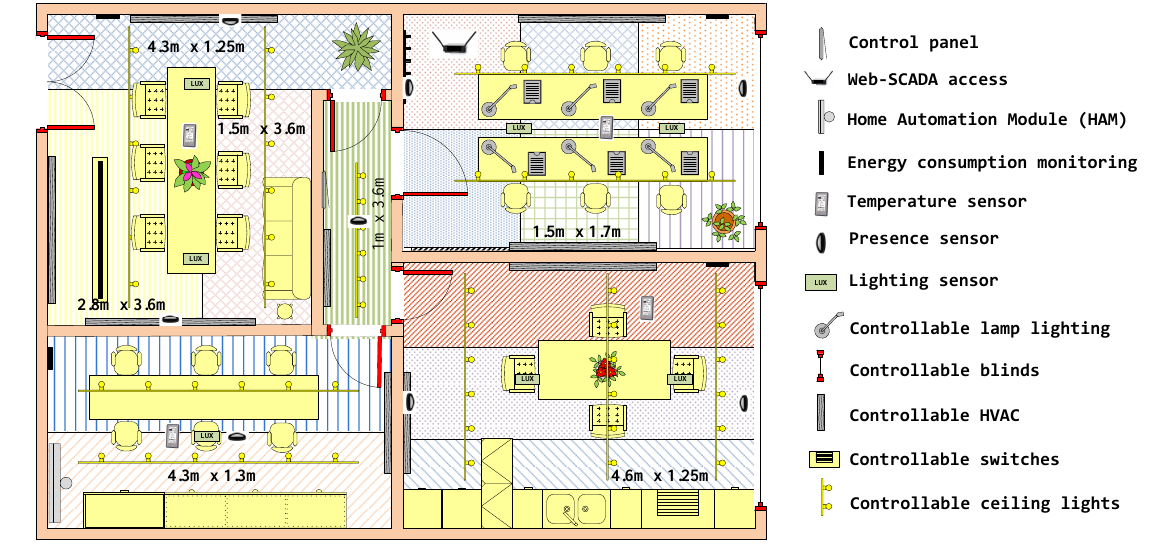
Figure 17. Reference scenario with the deployed sensors and